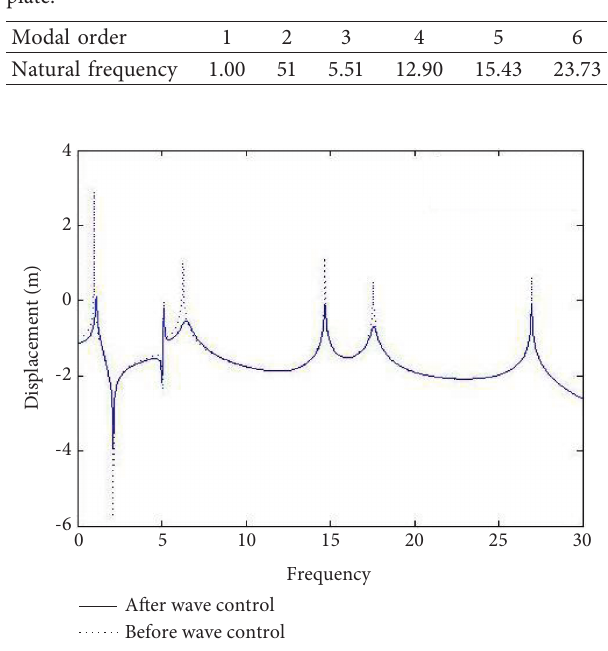
Figure 2: Frequency response before and after wave control.